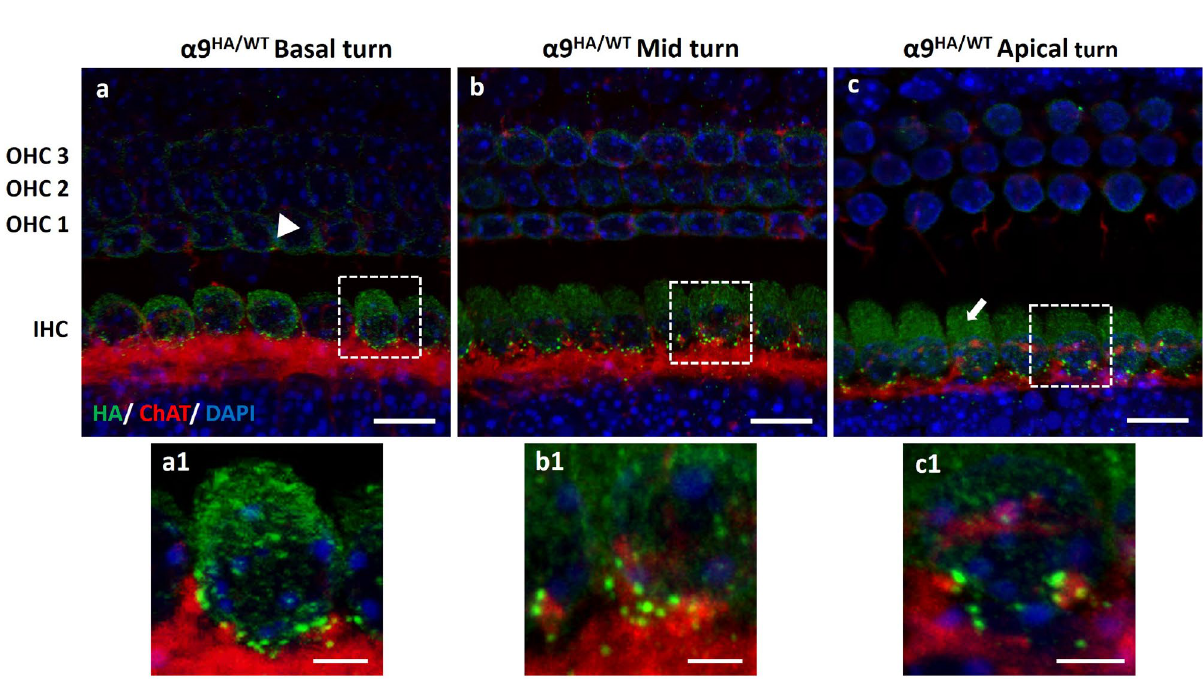
Figure 6. Expression of α9HA subunit in the developing cochlear sensory epithelium (P7–P8). Immunostaining of MOC axons with anti-ChAT antibody (red) and α9HA with anti-HA antibody (green). Insets ( a1 – c1 ) represent the magnification of a single IHC synaptic zone from each region of the cochlea represented above ( a–c ). Occasionally, α9HA immunopuncta are seen in the OHCs area, primarily in the first row (arrowhead, a ). Diffuse cytosolic labeling in IHCs is indicated by arrow ( c ). Nuclei are visualized by DAPI staining (blue). Scale bar: ( a )–( c ) 10 µm, ( a )–( c1 ) 2.5 µm. (α9 HA/WT N =